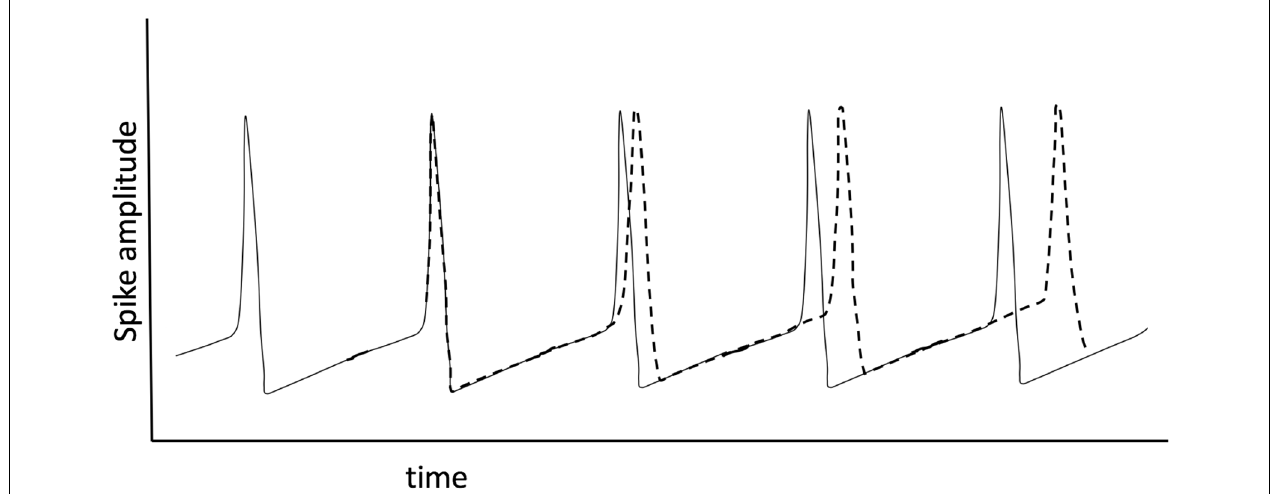
FIGURE 4 | Spiking of a relaxation oscillator (the basis for the Hodgkin-Huxley model), where an applied, continuing perturbation shifts (dotted line) the phase of the spike train going left to right. This shift can be viewed as a change in spike timing, phase modulation, or frequency modulation: they are all equivalent mathematically.